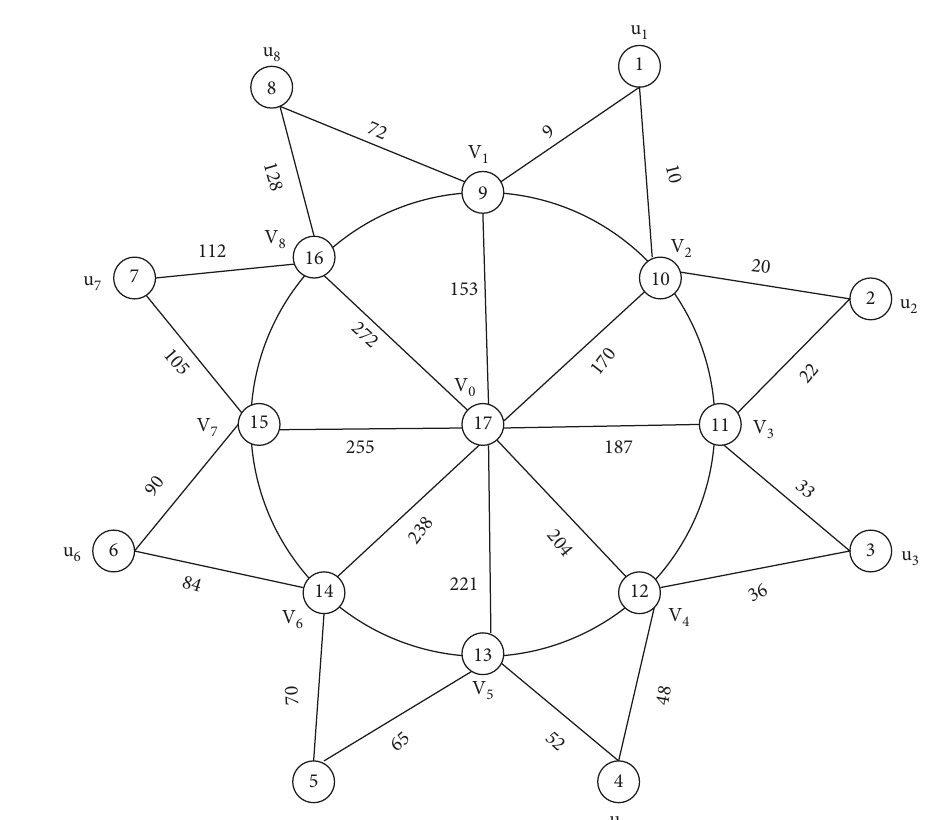
)( DC ) with strongly multiplicative labeling. 7 7